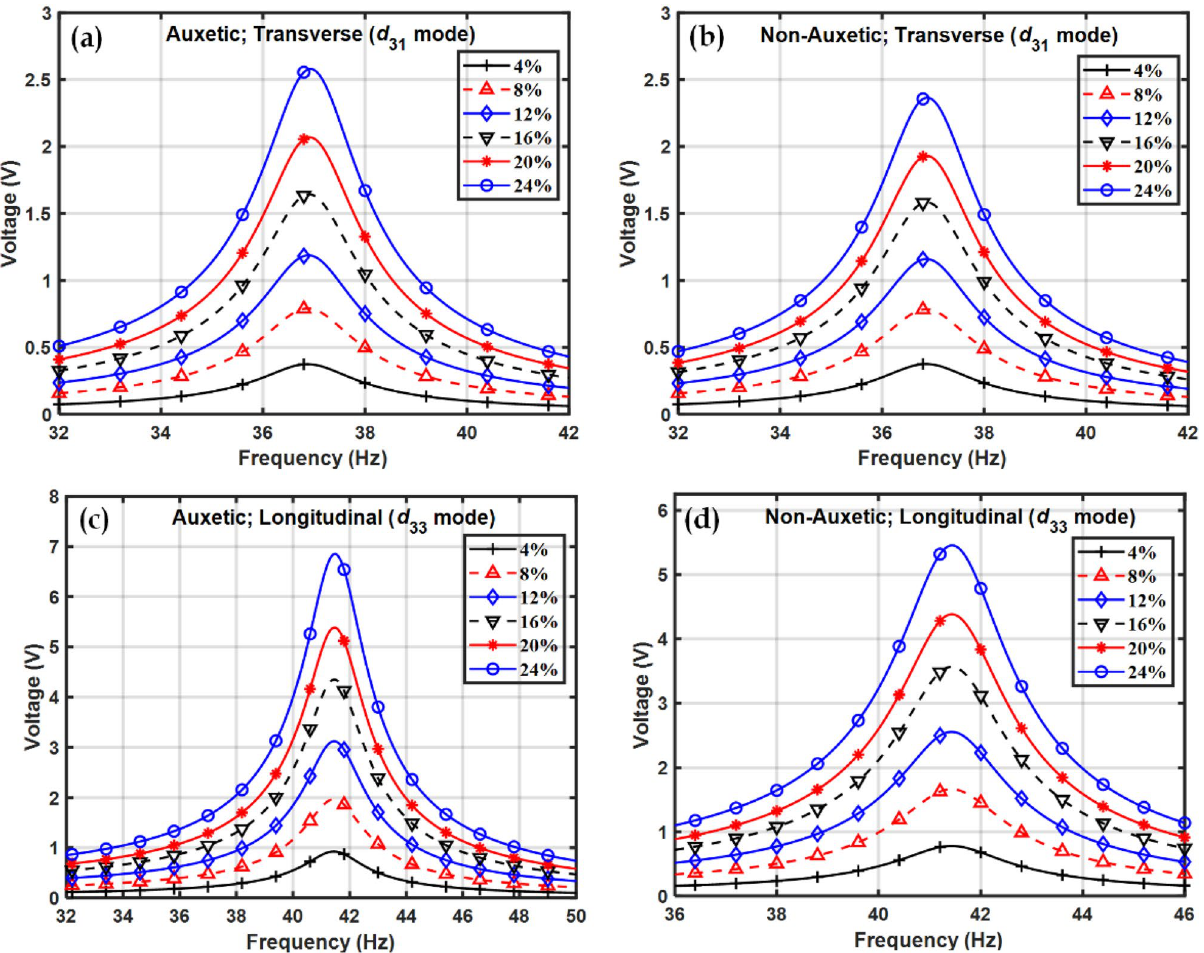
Figure 8. Voltage obtained from piezocomposite in the frequency domain at different volume fractions of BCZT in transverse ( d 31 ) mode for ( a ) Auxetic, ( b ) Non-Auxetic piezocomposite and in longitudinal ( d 33 ) mode of ( c ) Auxetic and ( d ) Non-Auxetic piezocomposite.